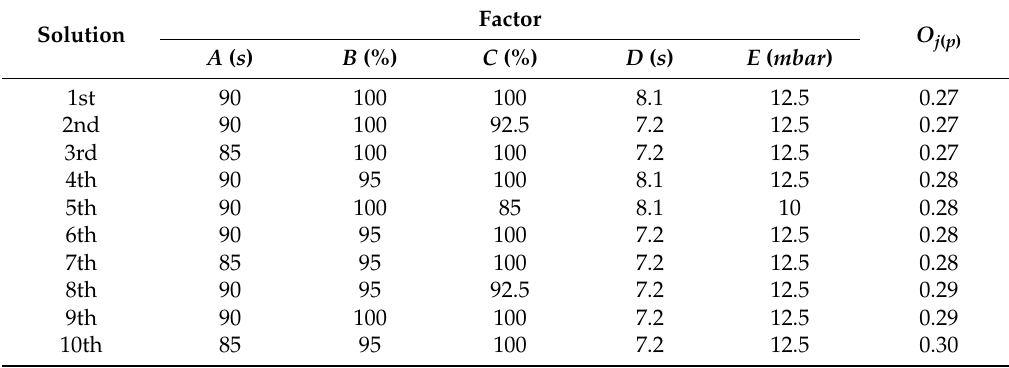
Table 6. Summary of the 10 best results of the “A” variation of the optimization algorithm.